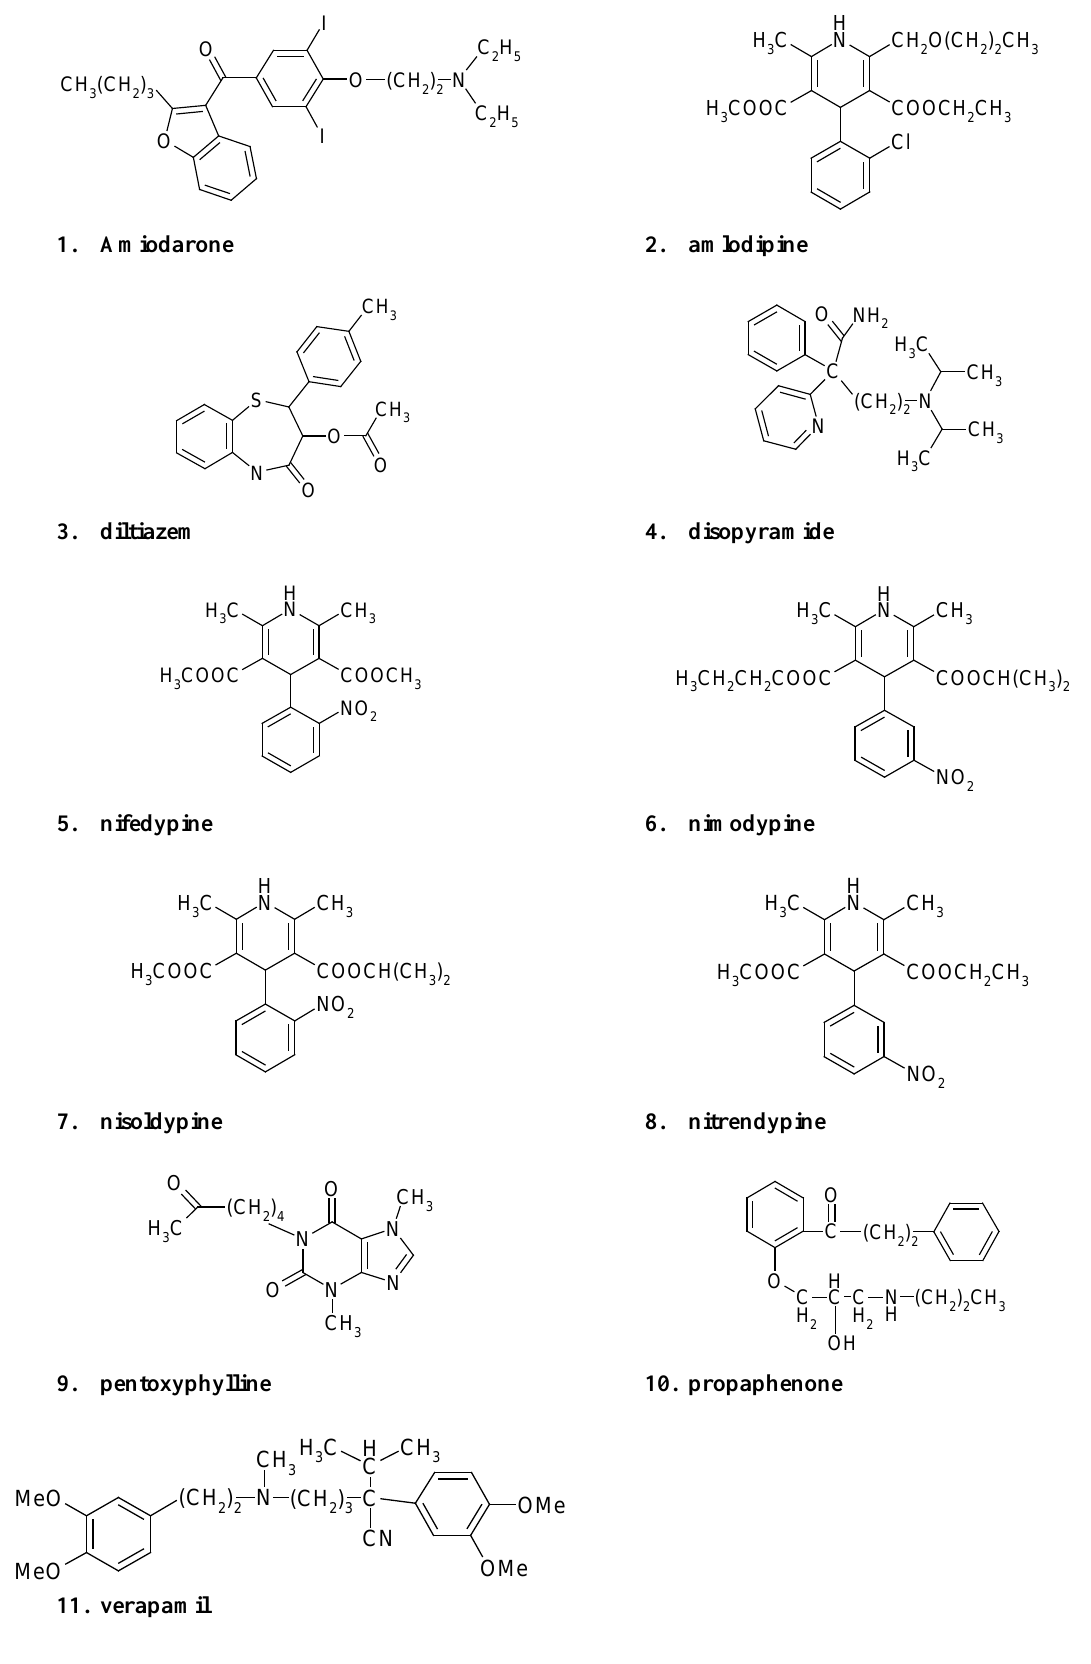
Figure 1. Chemical structures of the 11 studied